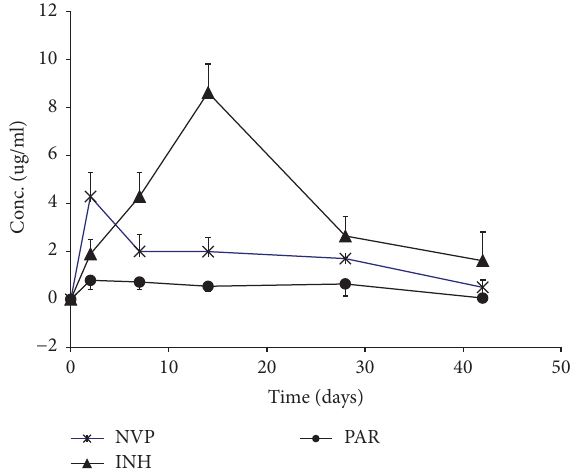
Figure 4: Plasma concentrations (mean ± sd) of NVP (stars), INH (triangles), and PAR (circles) in rats treated daily with NVP, INH, and PAR,